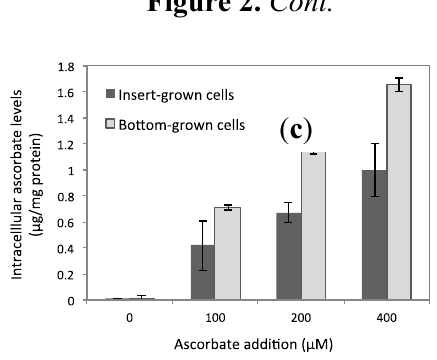
Figure 3. Iron ( 55 Fe) transport across the apical and basal borders. ( a ) Apical transport (uptake) of 55 Fe in response to intracellular/basal ascorbate (150 μ M) was increased compared to no ascorbate. The cells were incubated with ascorbate in the basal chamber for 24 h. Values are means of 10 samples ±SD. The difference between treatments was significant ( p = 0.04). ( b ) Basolateral transport of iron (as 55 Fe) in response to intracellular/basal ascorbate (150 μ M) was increased compared to no ascorbate. The cells were incubated with ascorbate in the basal chamber for 24 h. Values are means of 10 samples ±SD. The difference between treatments was significant ( p = 0.03). ( c ) Western Blot of cells treated with ascorbate (150 μ M). Lane 1: Control cells (no treatment). Lane 2: Basal ascorbate at 150 μ M; these were the ferroportin levels before iron addition in ( a ). Lane 3: Ferroportin levels 22 h after the iron addition (20 μ M for 2 h) in ( a